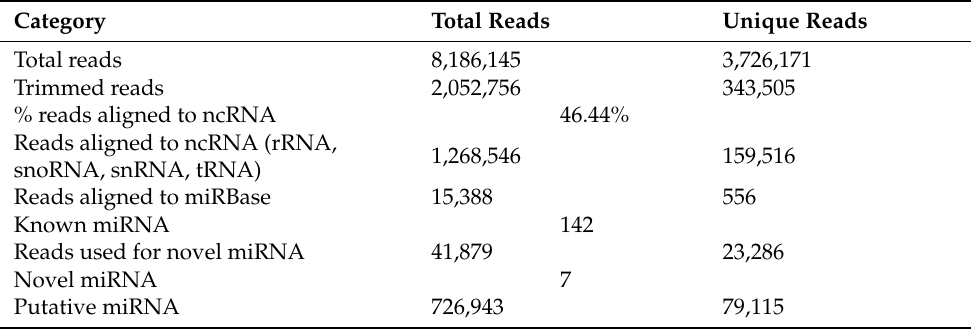
Table 1. Categorization of sequencing